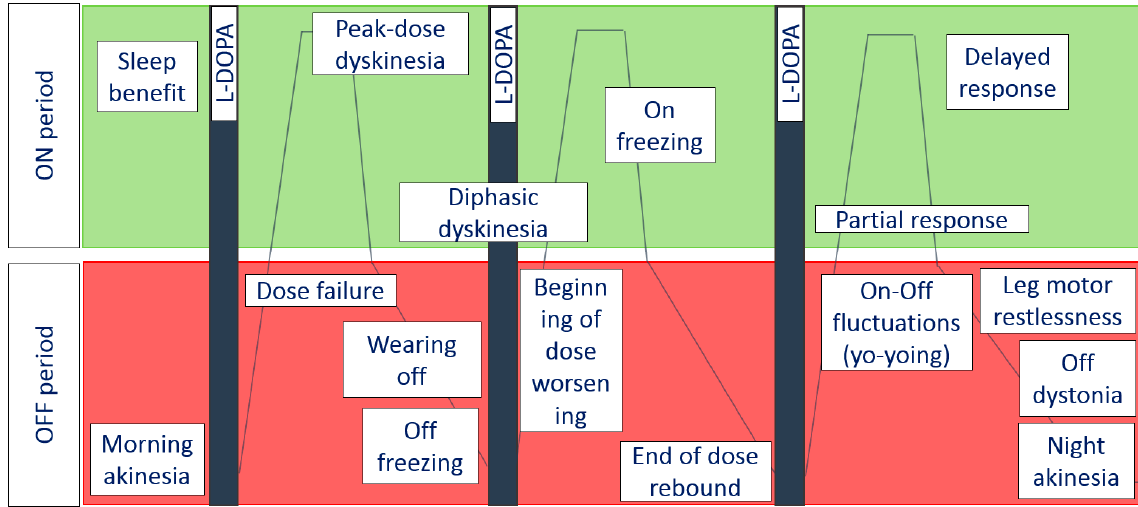
Figure 1. Motor complications of PD.